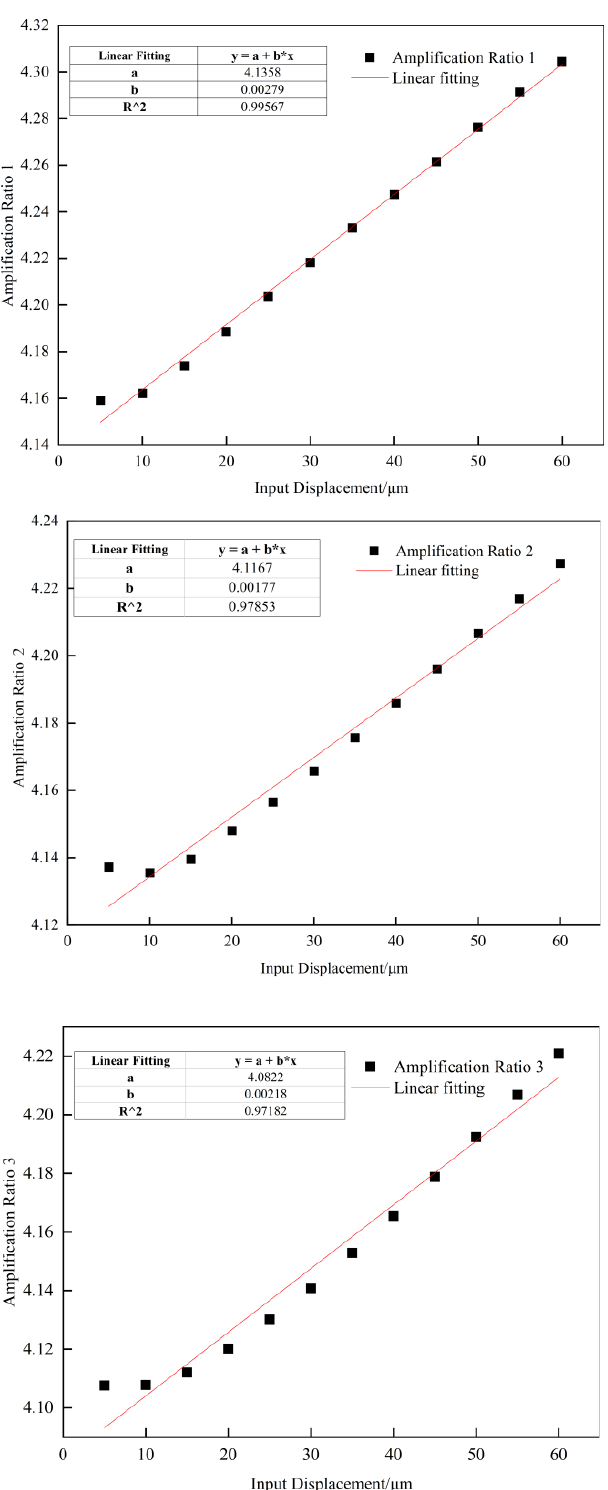
Figure 12. Curve fitting of amplification ratio function.